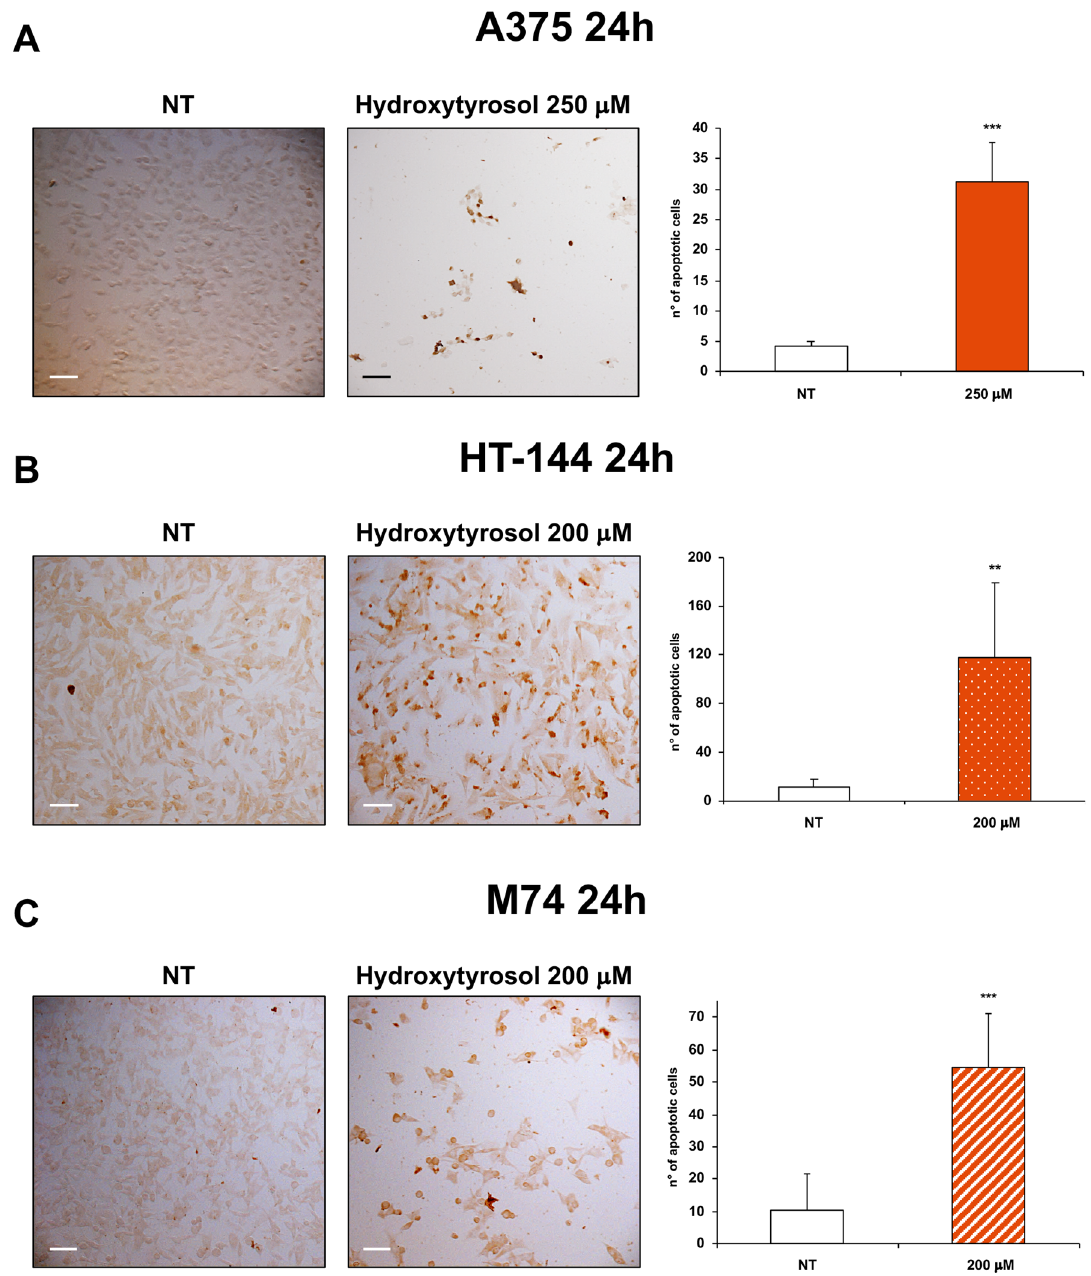
Figure 2. TUNEL analysis of hydroxytyrosol treated melanoma cells. A375 ( A ) cells were treated with 250 µ M of hydroxytyrosol, HT-144 ( B ) and M74 ( C ) cells were treated with 200 µ M of hydroxytyrosol for 24 h. Colorimetric TUNEL staining was used to analyse the apoptotic cells of A375 ( A ), HT-144 ( B ), and M74 ( C ) untreated (left panels) and treated (middle panels) cells. Images were acquired with a Zeiss Axioskop 2 Plus microscope using a × 10 objective. Scale bar: 100 µ m. The number of stained apoptotic cells were reported in the histograms (right panels). The data are representative of almost three di ff erent experiments, the error bars indicate the standard deviation, and statistical significance was analysed by the Student’s t -test: ** p < 0.01 highly significant; *** p < 0.001 very highly significant. Apoptosis is a form of programmed cell death whose dysregulation underlies physiological but also pathological processes including tumorigenesis [29]. In particular, in the early apoptosis, the lipid phosphatidylserine (PS) is translocated from the inner to the outer layer of the membrane